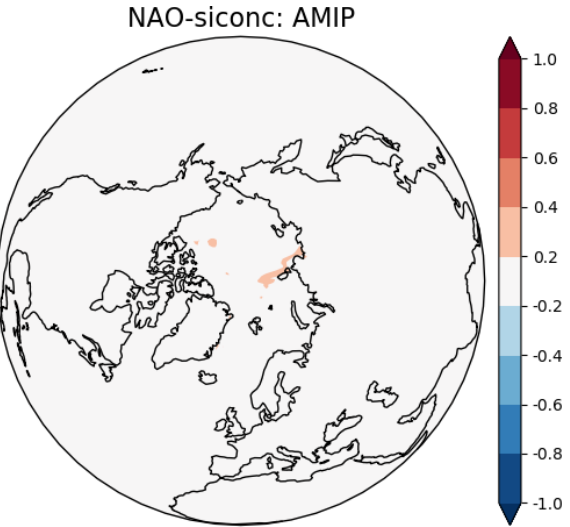
Figure B4. Correlations between the detrended November siconc anomalies at each grid point and the DJF NAO time series, using the AMIP ensemble. All three members have been concatenated. The period covered is